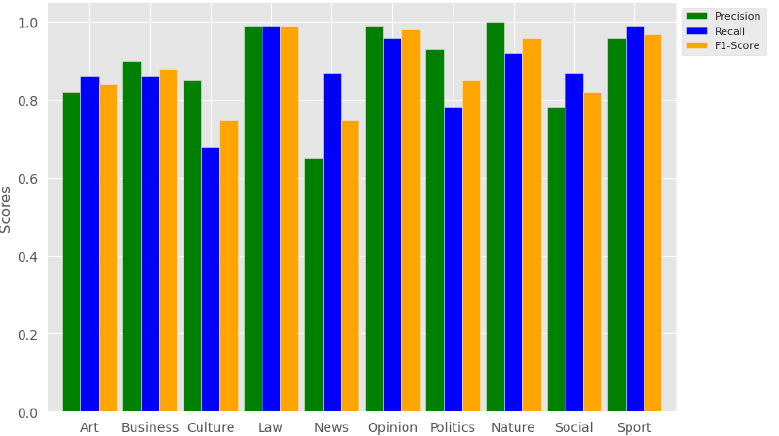
Figure 7. Comparing Performance of SVM with TF-IDF + SMOTE across